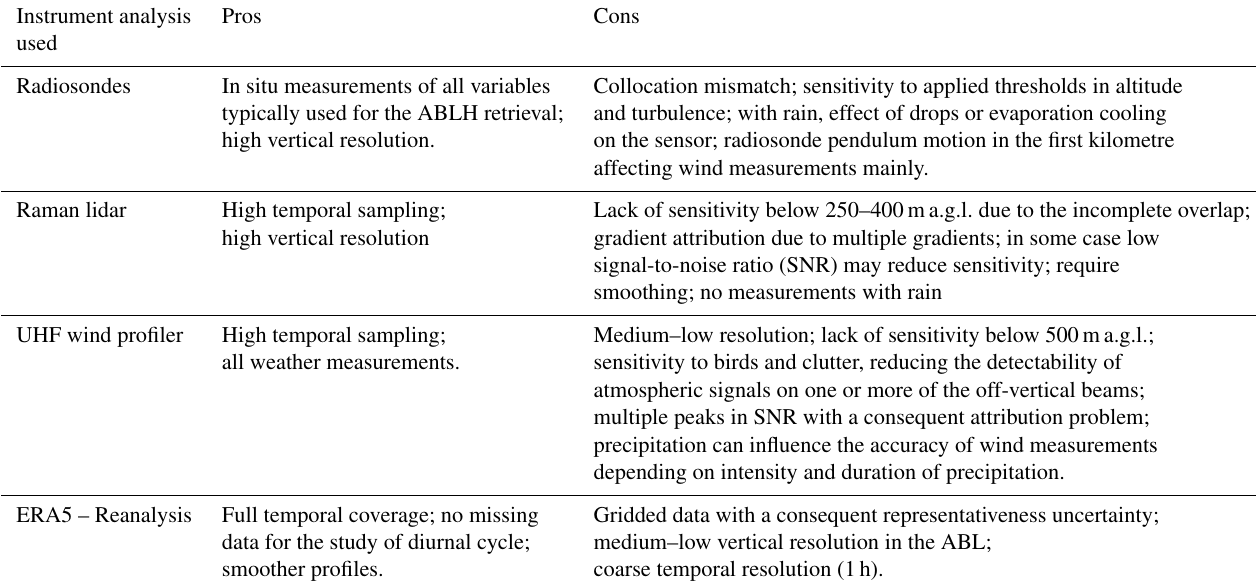
Table 1. Pros and cons of the considered instruments/reanalysis and their potential sources of bias. Instrument